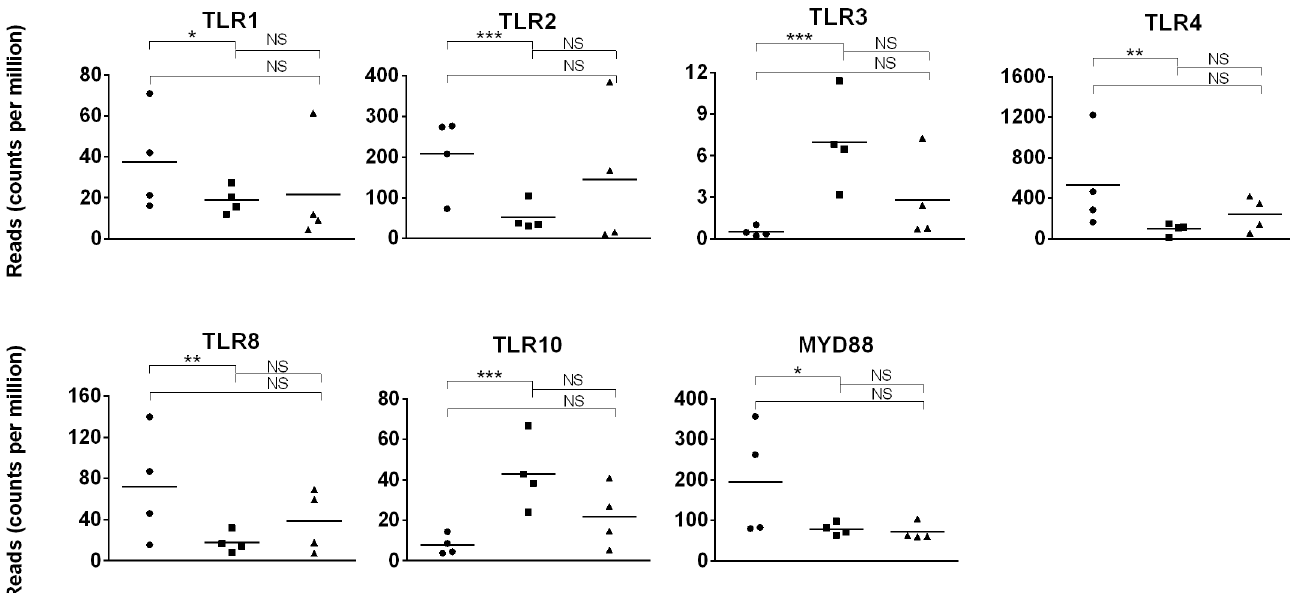
Fig 8. Toll-like receptor gene expression in day 1 foal, day 42 foal, and adult horse samples. Expression (quantified by number of reads on y-axis) of TLR genes in day 1 foal (circle), day 42 foal (square), and adult (triangle) samples are plotted on the x-axis. The significance level of comparisons is indicated by asterisks ( (cid:3) p < 0.05; (cid:3)(cid:3) p (cid:20) 0.001; (cid:3)(cid:3)(cid:3) p (cid:20) 0.0001); comparisons that did not differ statistically are labeled “NS” to denote not significant.